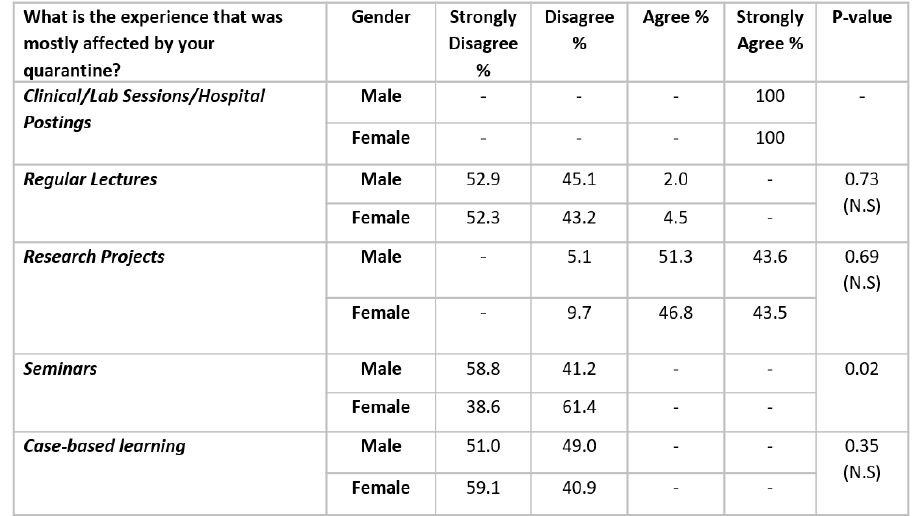
Table 5: Experiences mostly affected by quarantine based on Gender profile